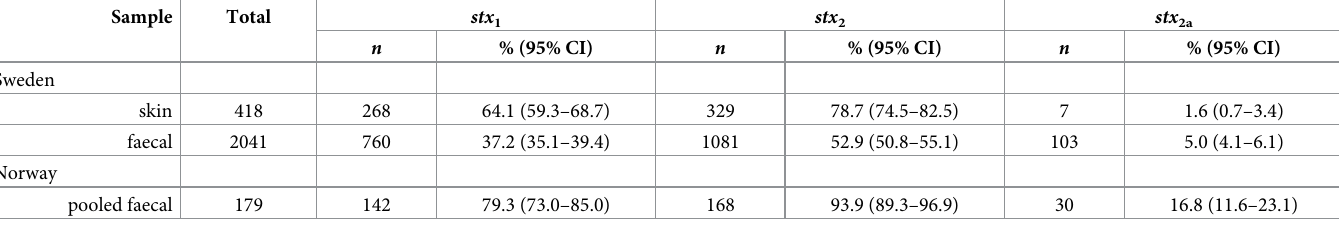
Table 3. Prevalence of Shiga toxin genes (with 95% CI) in Swedish dairy cattle and Norwegian dairy herds using different sampling procedures.